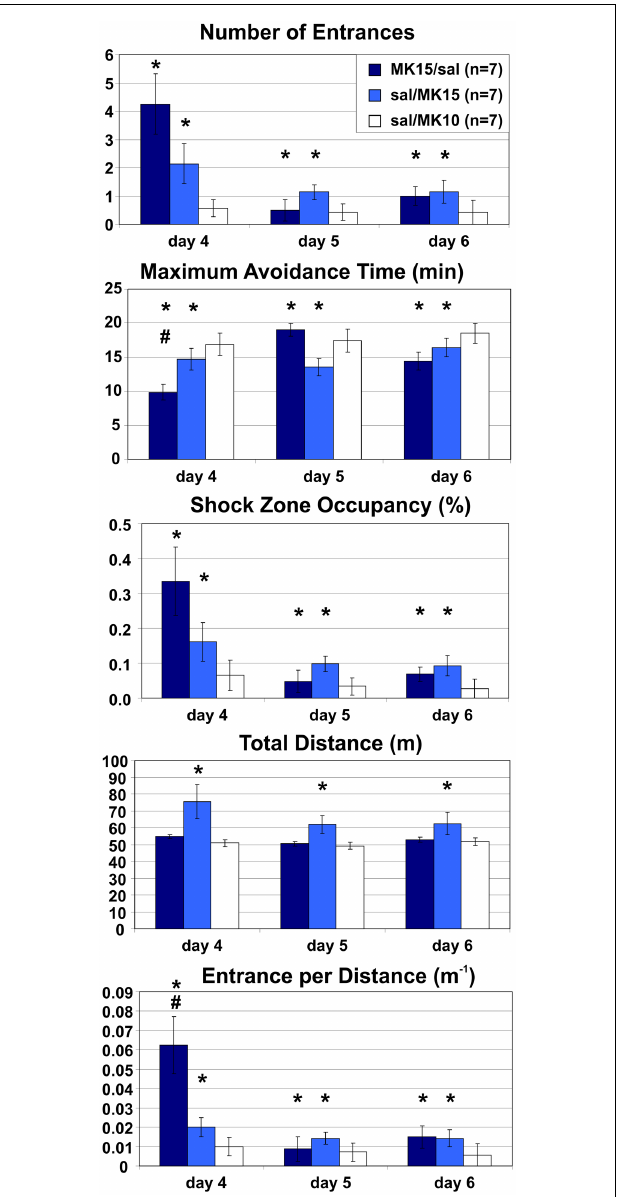
FIGURE 7 | Room-Rotating place avoidance after reversed injections . Rats trained with MK-801 (0.15mg/kg) on days 1–3 received saline on days 4–6 (MK15/sal) and rats initially trained with saline received MK-801 at 0.15mg/kg (sal/MK15) or 0.10mg/kg (sal/MK10). Rats in the sal/MK10 group avoided better than the other rats. Locomotion was increased in the sal/MK15 group. Switching from MK-801 to saline caused a marked but transient place avoidance deficit on day 4, which disappeared on the next day (MK/sal). Switching from saline to MK-801 (0.15mg/kg) caused a less dramatic, but more persistent place avoidance deficit. Significant effects of treatment are marked with asterisk (*) and a significant effect of treatment × session interaction is marked with number sign ( # ).